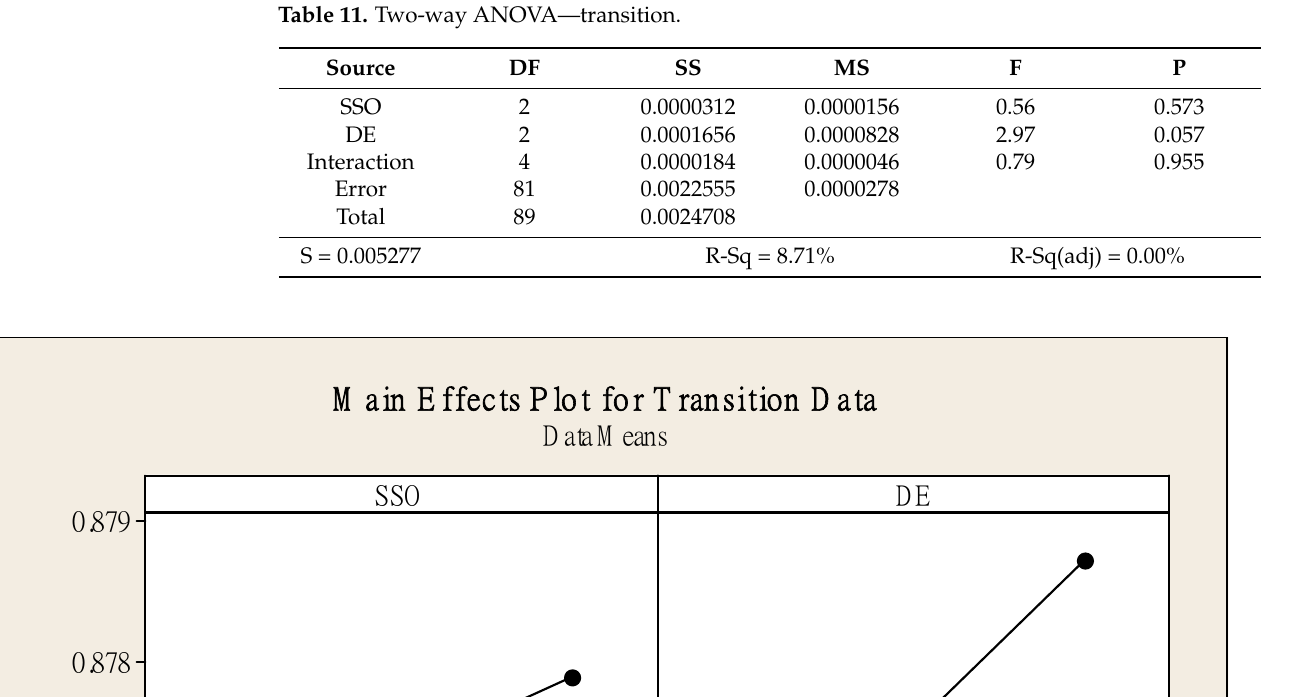
Table 11. Two-way ANOVA—transition.